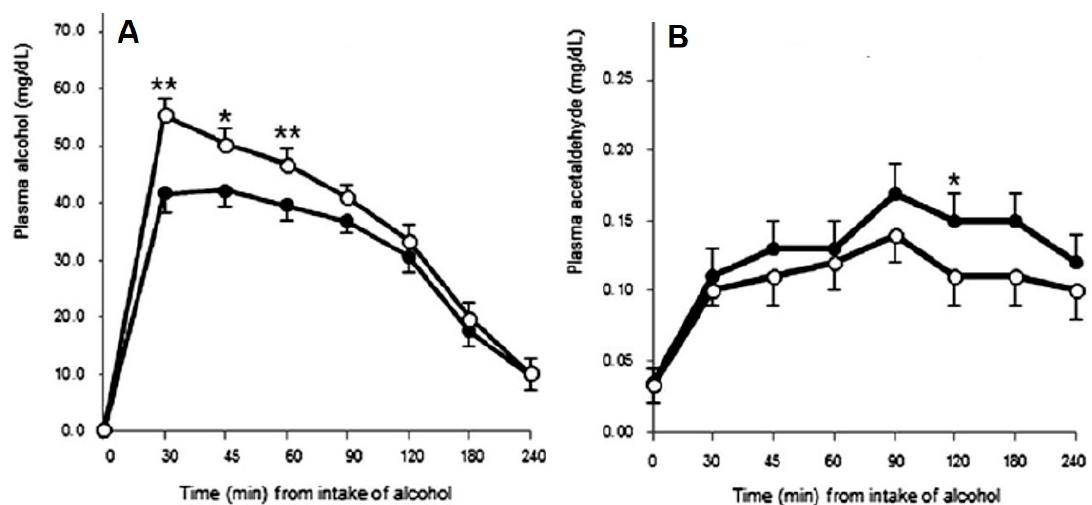
Figure 2. Effects of red ginseng on blood ethanol and acetaldehyde concentration. Alcohol and acetaldehyde levels over 240 min following alcohol intake in placebo ( ○ ) and test ( ● ) with red ginseng groups. ( A ) Alcohol levels in plasma; ( B ) acetaldehyde levels in plasma. Values are expressed as means ± SEM. p-values are from nonparametric paired t-tests. * p < 0.05, ** p < 0.01. Reproduced from reference [46], with permission from the Royal Society of Chemistry.